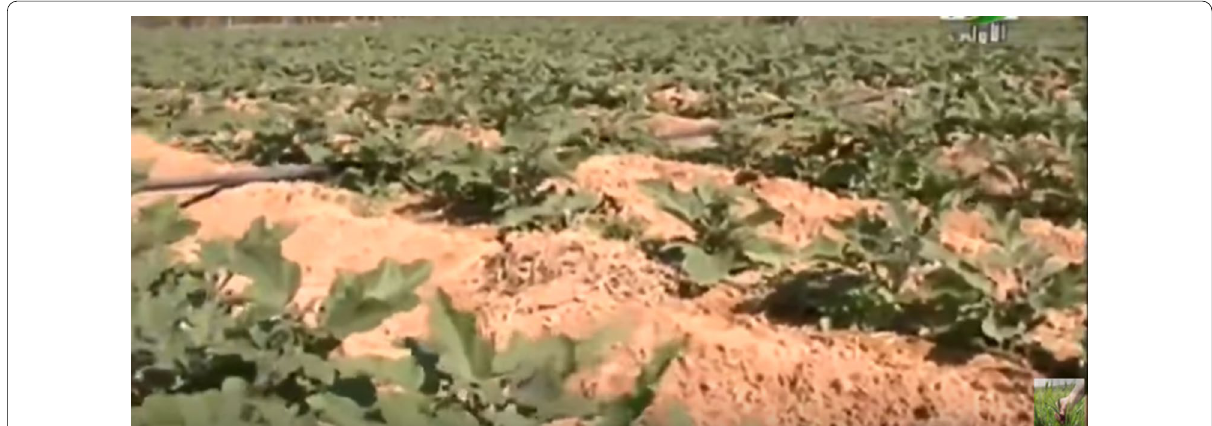
* The host range assumed by the producers on the product labels is not necessarily confirmed in neutral tests (Wilson and Jackson 2013) + The rates are evenly applied to the soil (except oxamyl for foliar application too). In some cases, these rates may be incorporated into potting mix, field soil, or applied in greenhouses for which other doses are used (Abd‑Elgawad 2020a)